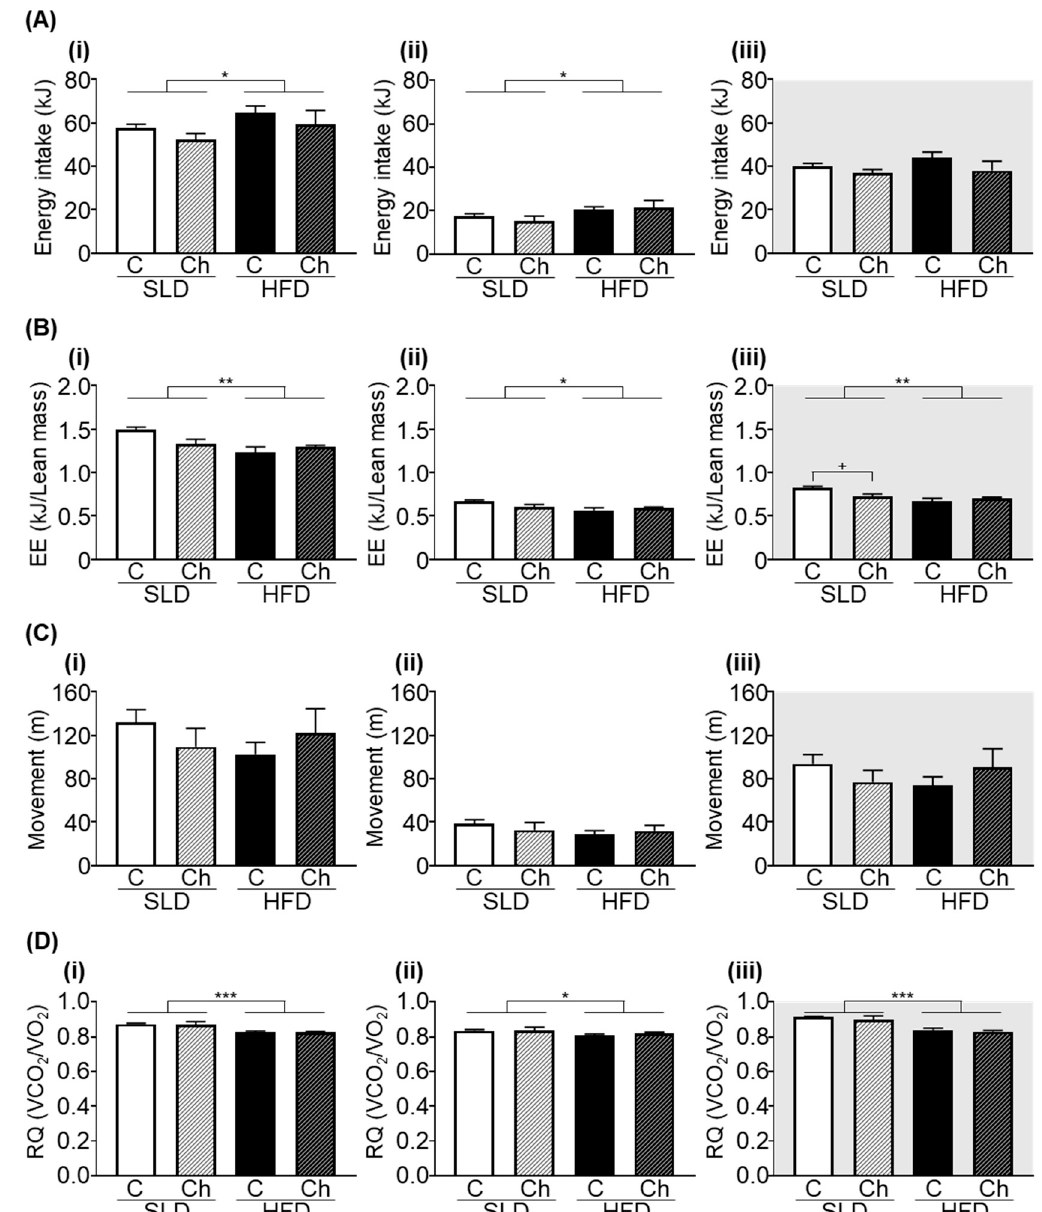
Figure 3. High fat diet (HFD) feeding but not the chronic isoleucine treatment a ff ects energy balance in mice. ( A ) Energy intake, ( B ) energy expenditure (EE), ( C ) activity (distance of movement), and ( D ) respiratory quotients (RQ), across 24 h ( i ), 12 h of day (light phase) ( ii ), and 12 h of night (dark phase) ( iii ) in a standard laboratory diet (SLD) and HFD-mice (SLD / HFD-Control (C) n = 16–20, SLD / HFD-Chronic (Ch) n = 8–10). Values are mean ± SEM. * p < 0.05, ** p < 0.01, *** p < 0.001, diet e ff ect; two-way ANOVA with Sidak’s post hoc test, + p <